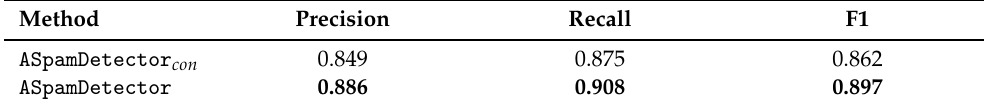
Table 5. Validating the importance of using the interaction graph.